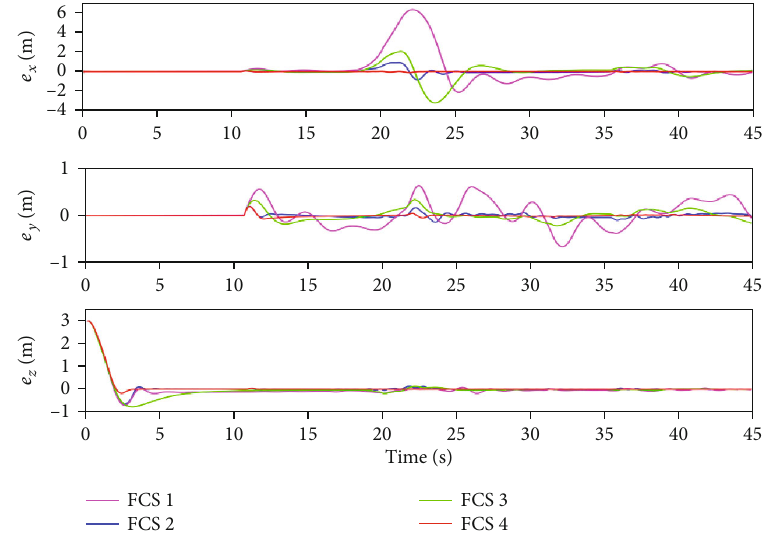
Figure 19: Evolution of the tracking errors for the translational subsystem ð e